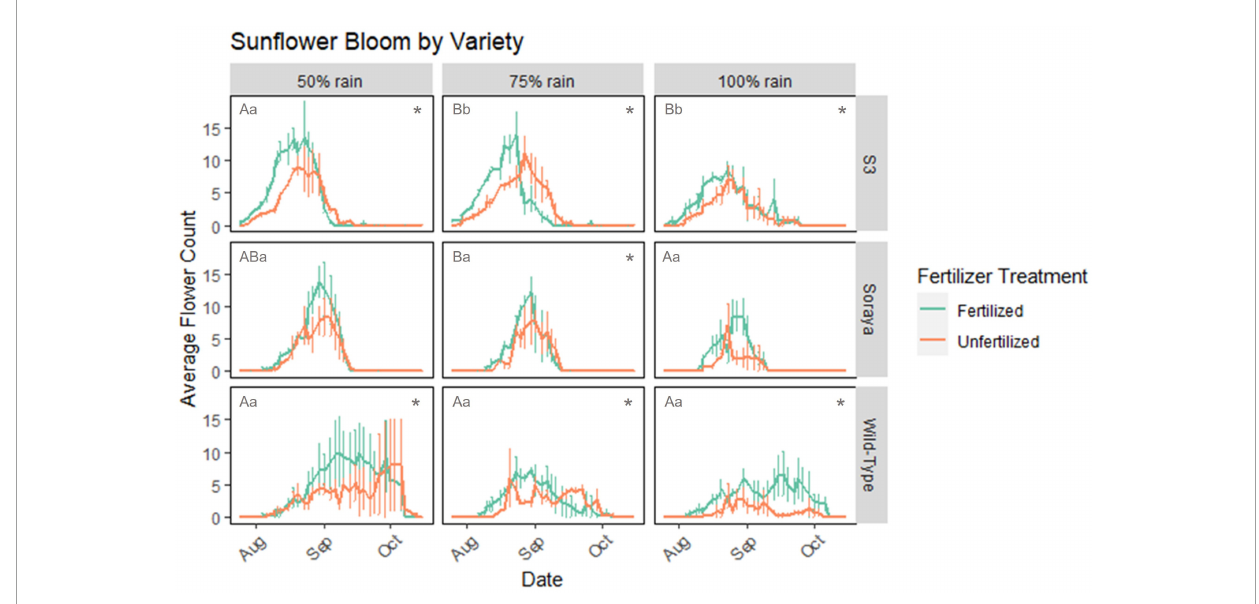
FIGURE5 Average number of flowering units in three sunflower varieties over time in 2021 (wet year). Number of flowers averaged over three replicate treatments of each rainfall and fertilizer treatment. Each replicate plot contained 4 Soraya plants, 2–3 S3 plants, and 1–2 Wild-Type plants. Fertilized treatments in green and unfertilized in orange. Each *represents statistical difference ( p < 0.05) in total flower days (not flowering rate) between fertilized vs. unfertilized plants. Upper case letters (AB) represent differences in total flower days with rain treatments among fertilized plants in a given sunflower variety (row). Lower case letters (ab) represent differences with rain treatment among unfertilized plants in a given variety. Error bars represent standard error.